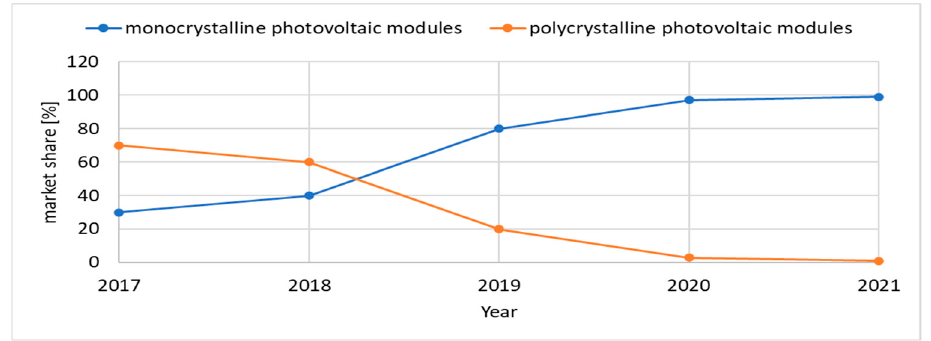
Figure 3. Market shares of individual types of photovoltaic modules in Poland (own compilation of data from IEO).